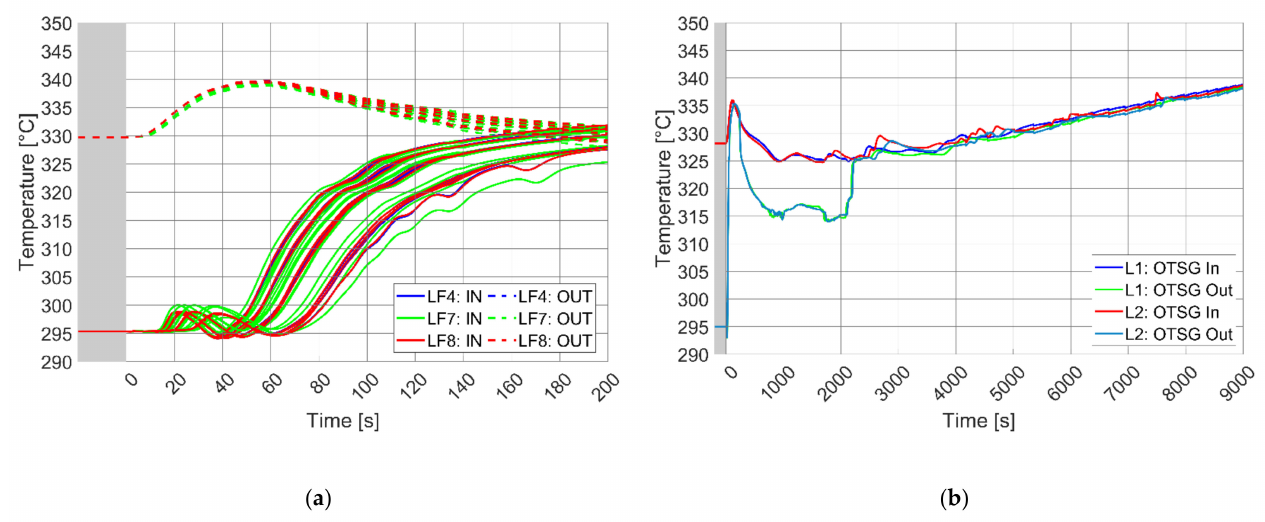
Figure 12. Parameter trends in BZ PHTS for LOFA transients characterized by natural circulation (LF4, LF7, LF8): ( a ) BZ PHTS water temperatures at BB inlet & outlet (all sectors, early time, COB segment); ( b ) BZ PHTS water temperatures at OTSGs inlet & outlet (full range, only